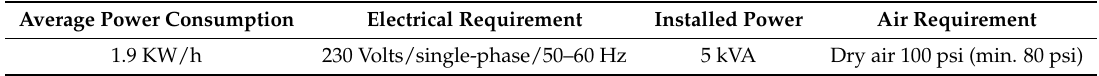
Table 2. Specification of the CNC bending